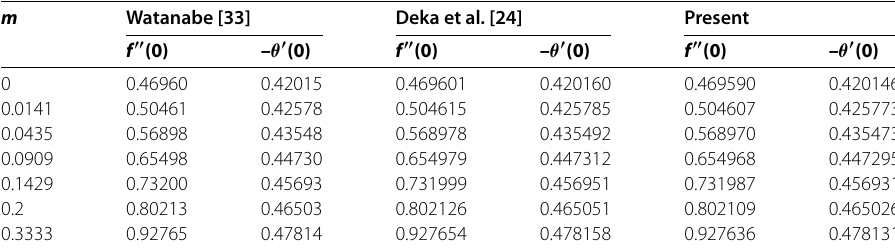
Table 1 Comparison of f (cid:2)(cid:2) (0) and – θ (cid:2) (0) for various values of m with P r = 0.73 and f w = 0 when θ r → ∞ m Watanabe [33] Deka et al.